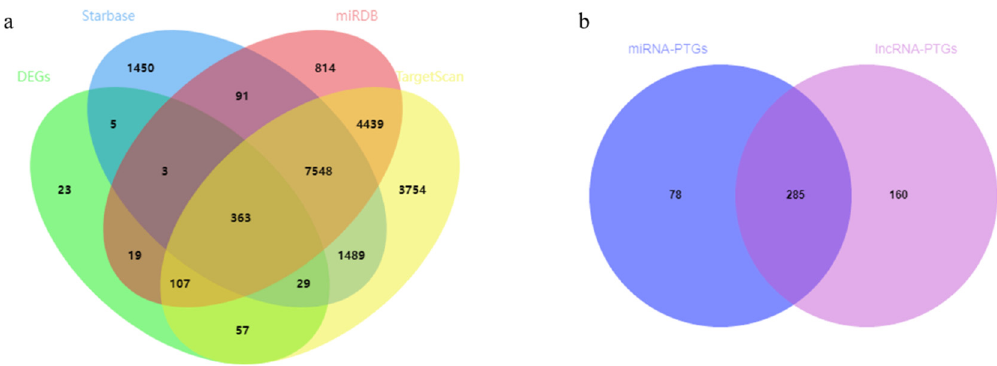
Figure 4. Venn diagram of target genes of differentially expressed miRNA and lncRNA. ( a ) Venn diagram of target gene prediction results of differentially expressed genes (DEGs) and three websites; ( b ) Venn diagram of target genes of differentially expressed miRNA (DEMs) and differentially expressed lncRNAs (DELs).